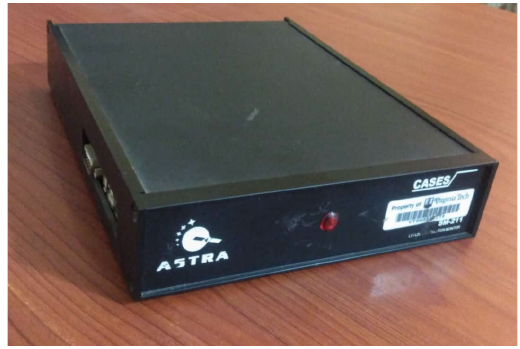
Figure 2. Photo of a CASES GPS receiver.